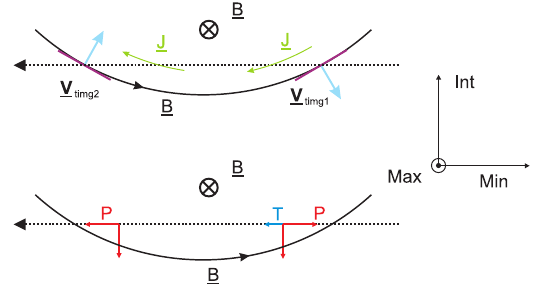
Fig. 17. Schematic of the main results of the 13 August 2003 flux rope in the same format as Fig.